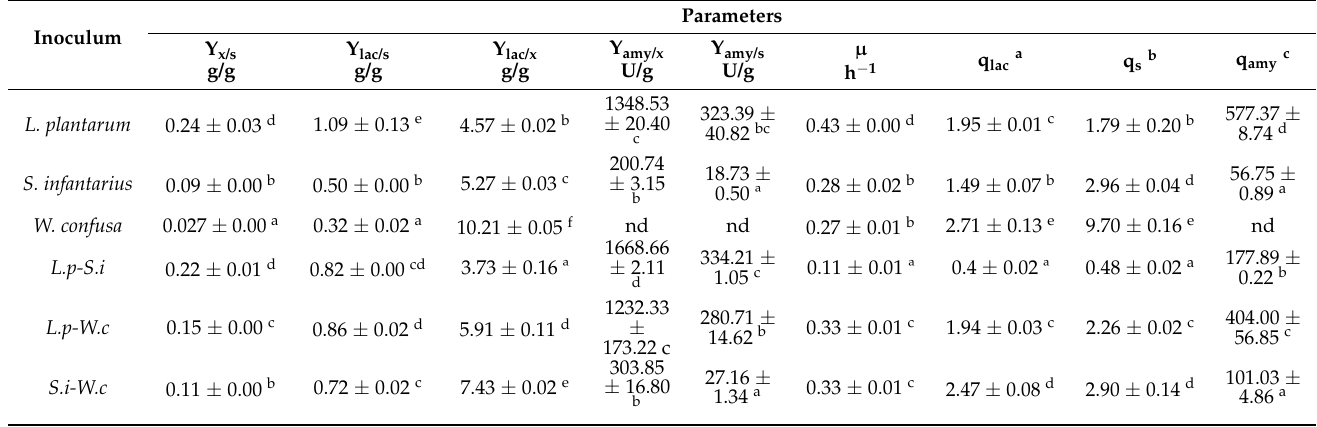
Table 1. Kinetic parameters of starch fermentation by pure and mixed culture of LAB. Different lowercase letters in the same column show significant differences according to the analysis of variance at p ≤ 0.05 (LSD test). Parameters Inoculum Y